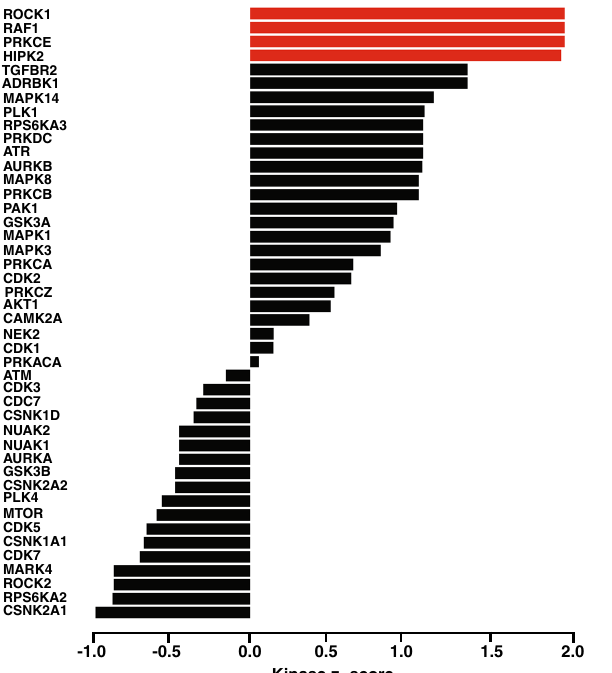
Figure 4. Alteration of protein kinase mediated signaling. Kinase–Substrate Enrichment Analysis (KSEA) tool scores each kinase based on the relative hyper or hypophosphorylation of its substrates. The positive or negative score implies increase or decrease in kinase’s overall activity as compared to the control. The kinases which are color coded in red are significantly activated in shammah treated oral